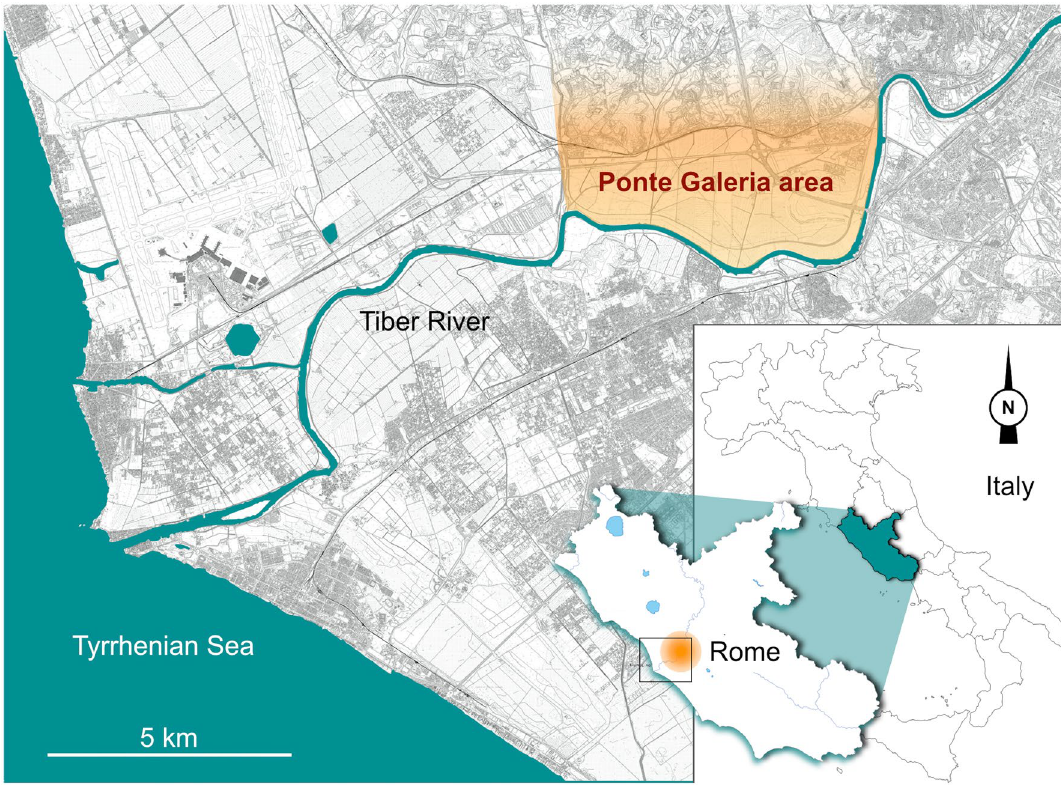
Figure 2. Geographic location of Ponte Galeria area. Map of Italy modified from https:// it. wikip edia. org/ wiki/ File: Italy_ map_ with_ regio ns. svg, map of Rome modified from the Carta Tecnica Regionale 2014 del Lazio, foglio 386—Lido di Ostia—https:// geopo rtale. regio ne. lazio. it/ layers/ geodb gt: geono de: curve_ livel lo#